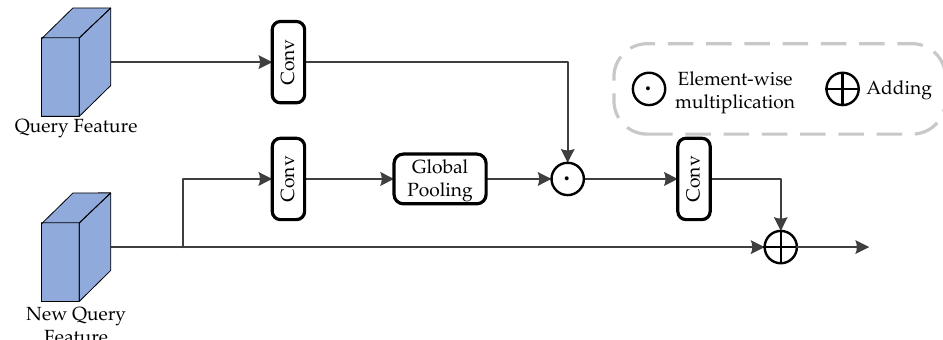
Figure 3. Method of multilevel features guide segmentation in the decoder